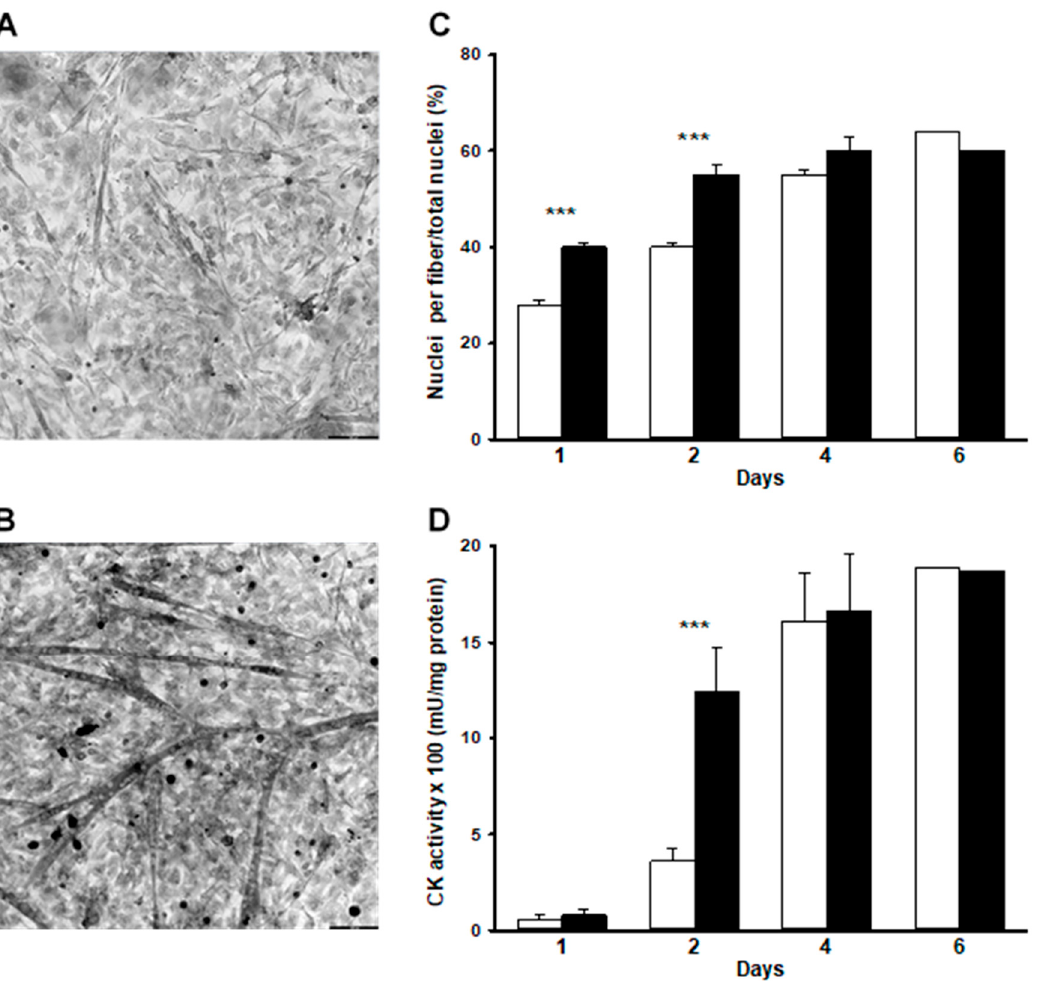
Figure 1. Effect of WEF on myoblast differentiation. Muscle cultures were either untreated (control) or exposed to WEF for up to six days. ( A ). Representative cell morphology using phase contrast microscopy for cells grown under control conditions for 1 day and ( B ). during exposure to WEF for one day (bar = 100 µm). ( C ). Presence of nuclei in myotubes over time in control ( ) and during exposure to WEF ( ). Values are mean ± SE for 13–23 dishes (except for 6 days where only one dish was examined). ( D ). Creatine kinase activity over time in control ( ) and during exposure to WEF ( ). Values are mean ± SE for 13–15 dishes (except for six days where only one dish was examined). *** p < 0.001 between groups at indicated day.